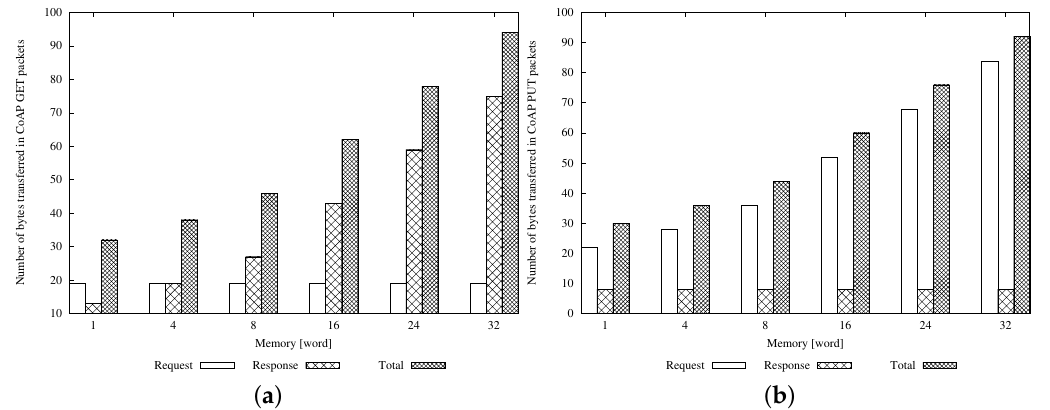
Figure 9. Amount of transferred bytes in CoAP: ( a ) GET; and ( b ) PUT